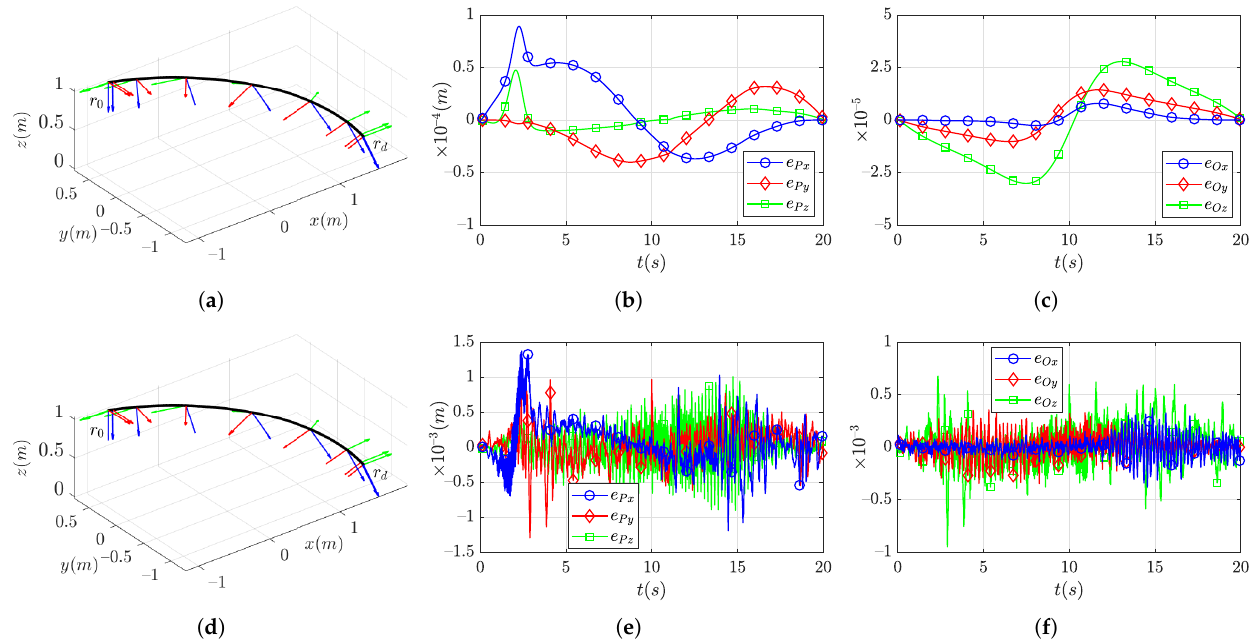
Figure 11. Tracking performance comparison between simulations and experiments for elliptic trajectory. End-effector’s trajectory in simulations ( a ) and experiments ( d ). Position errors in simulations ( b ) and experiments ( e ). Orientation errors in simulations ( c ) and experiments ( f ). Notice that the position and orientation errors, panels ( b , c ), respectively, are small in the simulations. In addition, notice that the trajectories in simulations ( a ) and experiments ( b ) are quite similar. The reason for the larger errors obtained in the experiments (panel ( e , f )) are discussed in Section